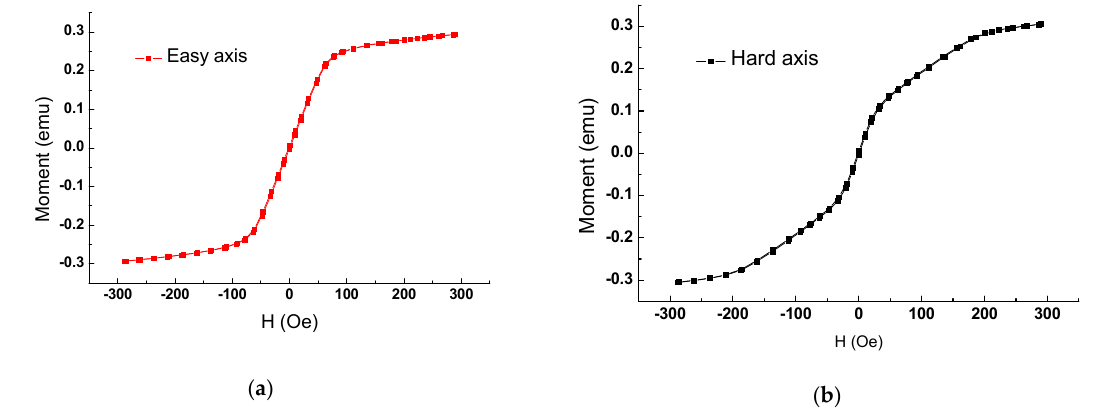
Figure 1. The magnetic hysteresis loop of the NiFe film: ( a ) easy axis ( b ) hard axis [11]. Fe-based commercial amorphous ribbons (Metglas 2605S, Conway, SC, USA) were purchased